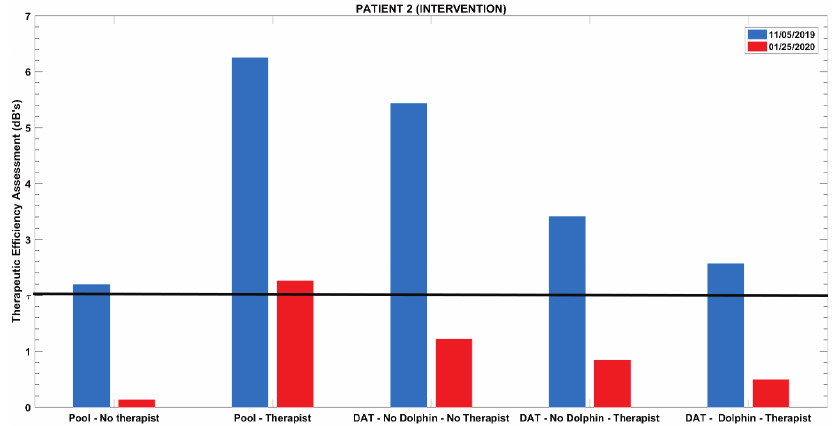
Figure 20. Results of the Patient 2 (Intervention), On 11/05/2019 and 01/25/2020. Continuous line indicates an efficiency threshold of ± 2 dB of TEA.